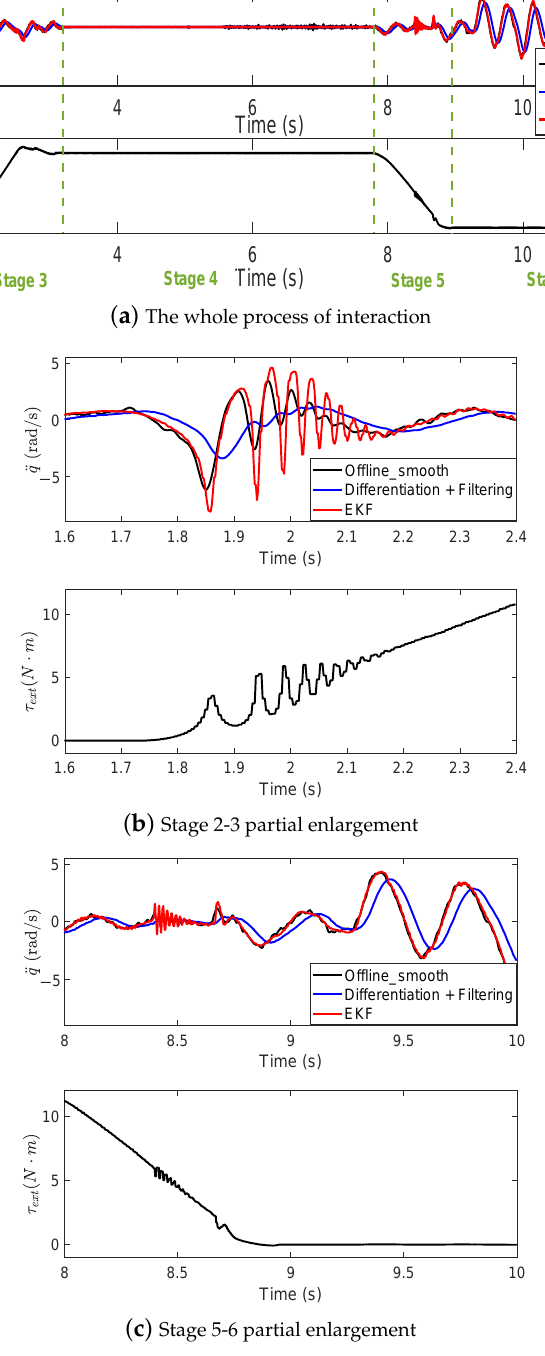
Figure 15. The link state in different stages of system